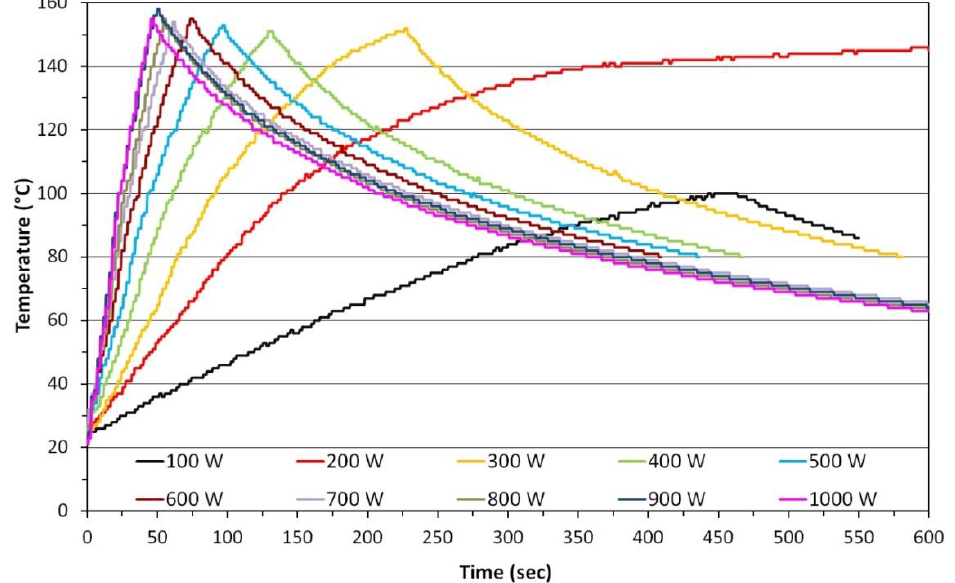
Figure 14. Kinetics of heating of 70 mL of distilled water, depending on the power emitted by the magnetron. Source: Experimental data achieved in the MSS3 reactor (IHPP PAS). Table 4. Summary of durations of microwave heating of a 70 mL distilled water sample. Source: Experimental data achieved in the MSS3 reactor (IHPP PAS).